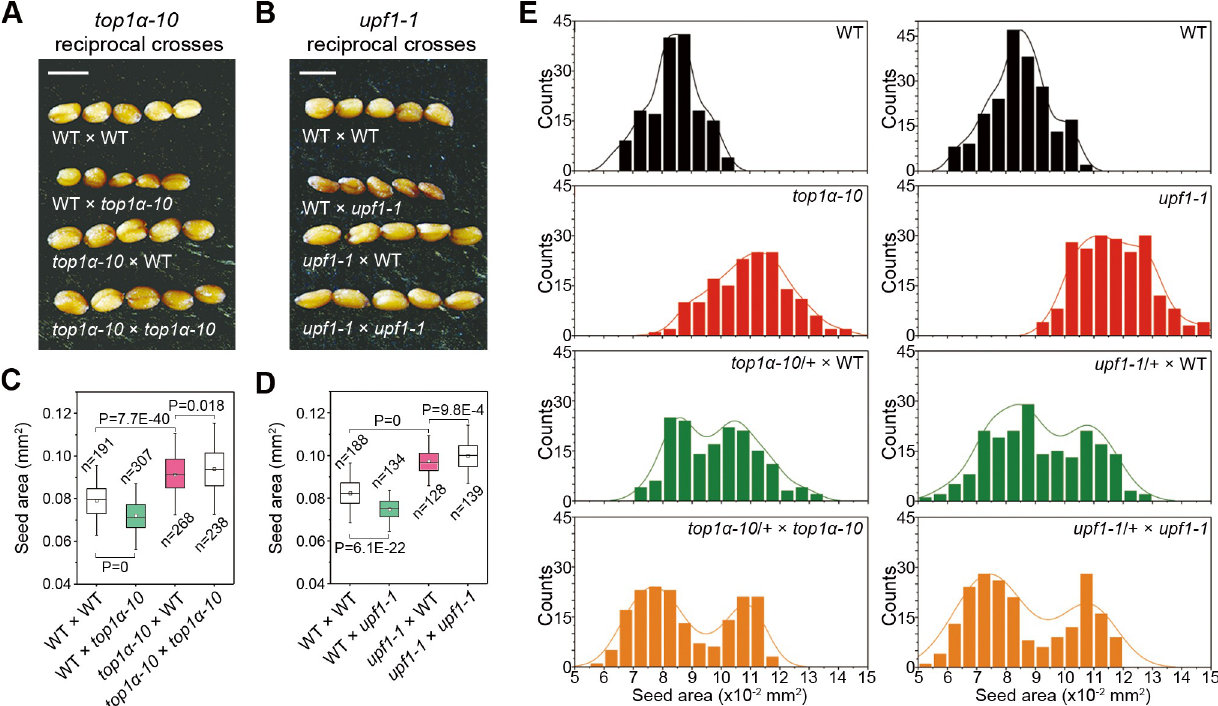
Fig 2. top1 α -10 and upf1-1 exhibit a parent-of-origin effect on diploidy crosses. (A) Representative seeds from reciprocal crosses between WT and top1 α -10 . Scale bars, 0.5 mm. (B) Representative seeds from reciprocal crosses between WT and upf1-1 . Scale bars, 0.5 mm. (C, D) Parent-of-origin effect of top1 α -10 (C) and upf1-1 (D) pertaining to seed size. (E) Histograms of the size distributions of seeds produced by top1 α -10 -related testcrosses (left panels) and upf1-1- related testcrosses (left panels). The distribution curves were determined by kernel-density estimation. The data underlying this figure are included in S1 Data. WT, wild-type plants.